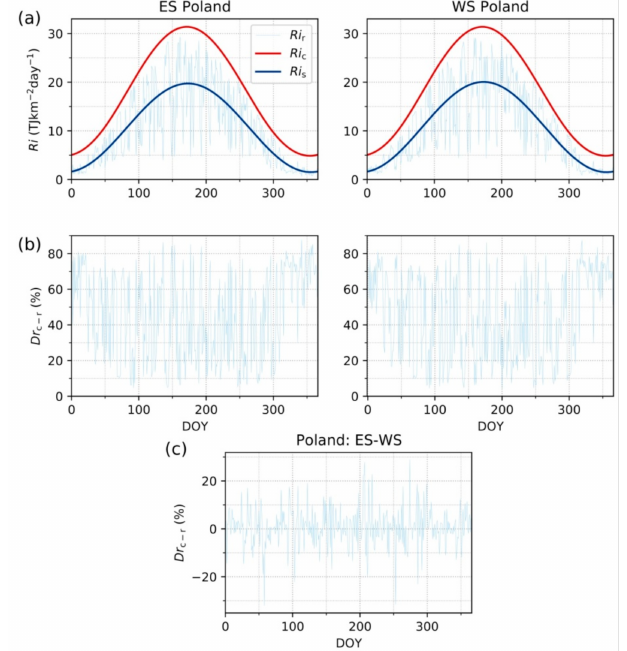
Figure 5. Annual variations for the ES and WS Landsat images (scene numbers 187/024 and 190/024) in Poland in 2014 in: ( a ) real daily amount of shortwave radiation ( Ri r ) and averaged (smoothed by Equation (5)) real amount of shortwave radiation ( Ri s ) reaching the centers of the scenes against the background of corresponding value calculated for perfectly clear-sky conditions ( Ri c ); ( b ) deviation of the Ri r value from its Ri c counterpart ( Dr c-r ), expressed as a percentage of the Ri c value; ( c ) difference between the D rc-r values calculated for the two